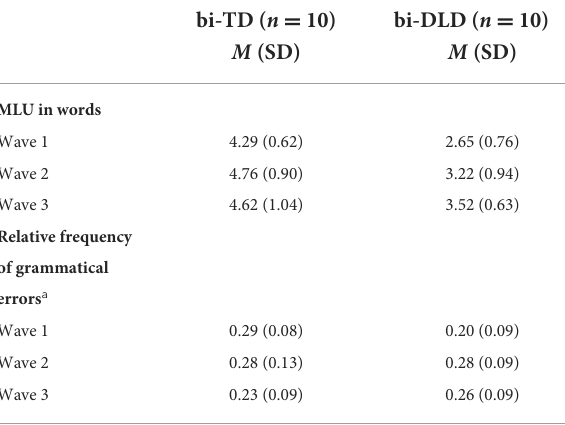
TABLE 5 Mean length of utterance (MLU) and relative frequency of grammatical errors in Dutch.